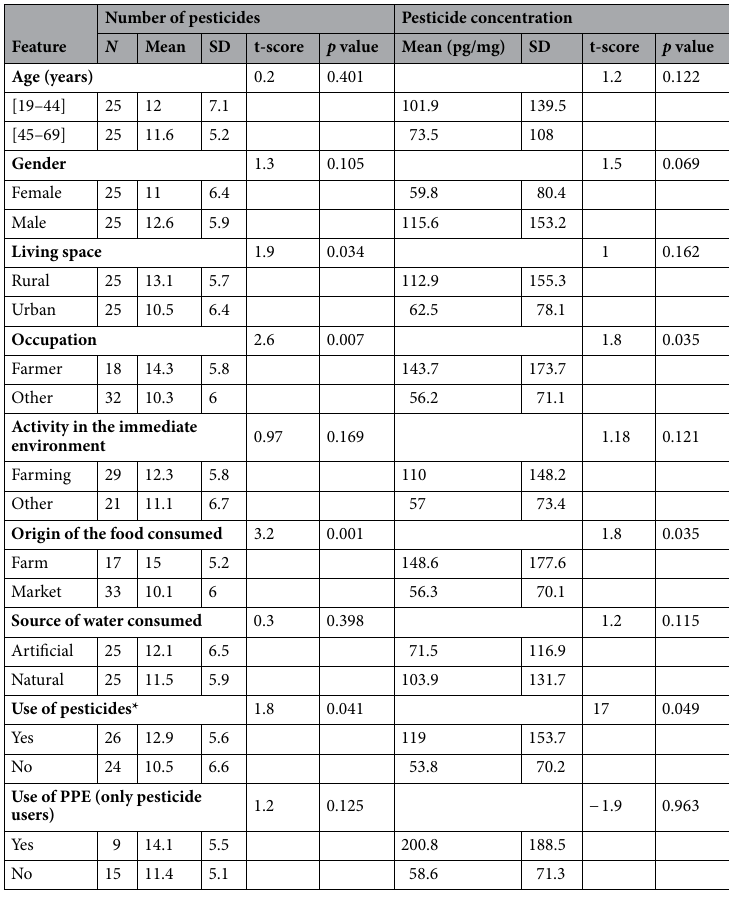
Table 3. Results of the bivariate analysis between socio-demographic factors and pesticide contamination in the hair of the 50 adult Peruvian participants in the study. t -tests were performed with log-transformed mean values. *Defined herein as either occupational or domestic use of